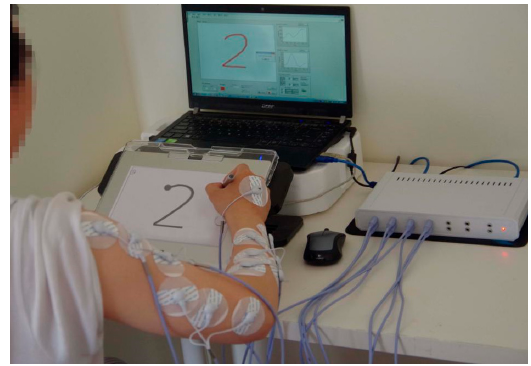
Figure 3. A photograph of one subject in the task stage.